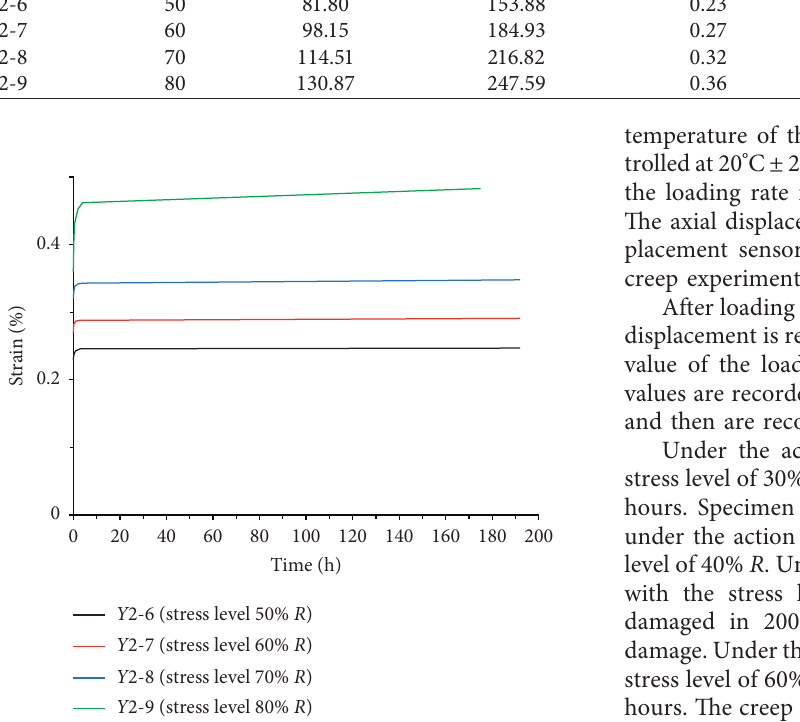
Figure 4: Creep curve of the iron ore